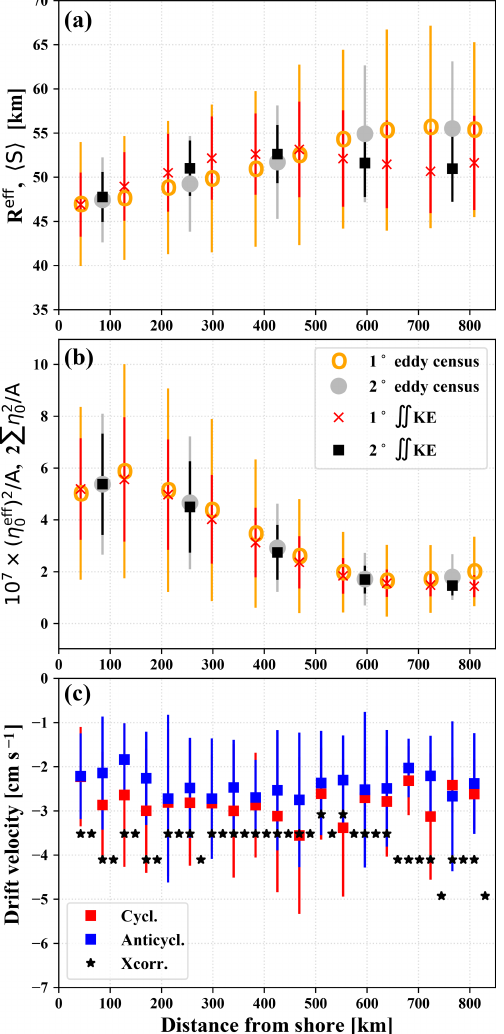
in 0 Figure 7. (a) Fitted mean super-vortex radius R eff and mean eddy scale (cid:104) S (cid:105) from eddy census, determined in meridional bands and plotted as a function of mean distance from the shore. (b) Square (cid:16) (cid:17) 2 η eff of fitted mean super-vortex height and the sum of squares 0 of all individual eddy heights P η 2 normalized by the area of in- 0 tegration or eddy census A . (c) Estimated westward drift velocities by evaluating the cross-correlation function (Eq. 6) and from vortex tracking of MEs living at least